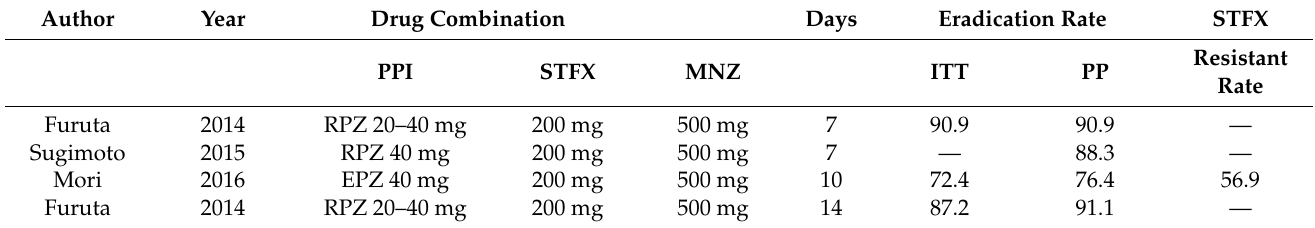
Table 3. Efficacy of PPI–sitafloxacin (STFX)–metronidazole (MNZ).